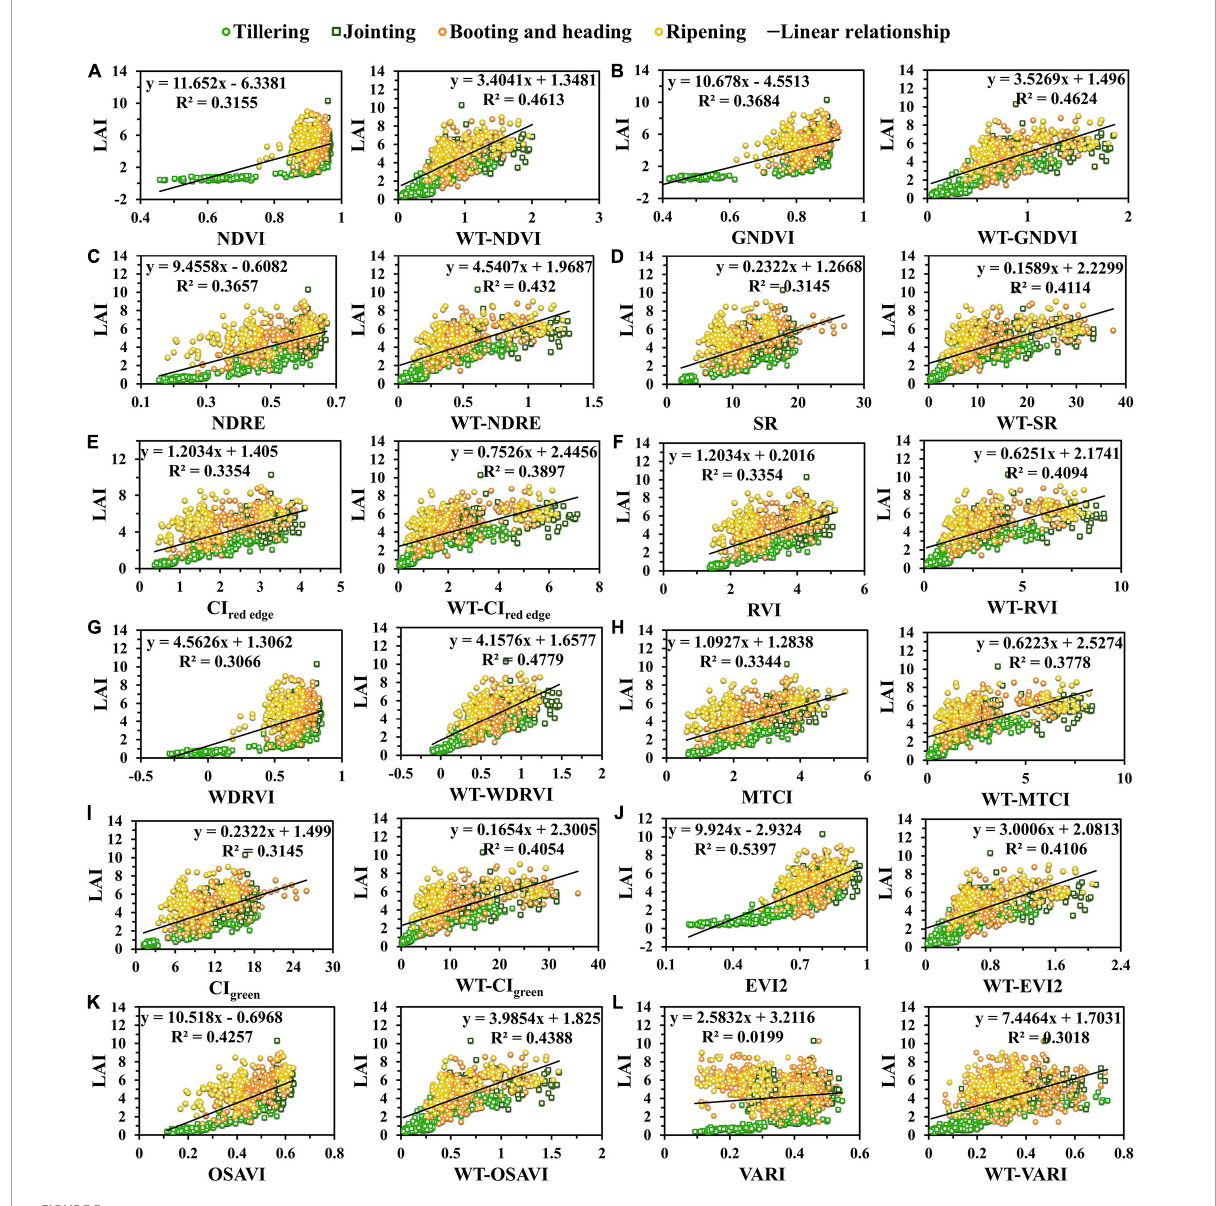
FIGURE5 Two models of VIs and WT-VIs: (A) NDVI, (B) GNDVI, (C) NDRE, (D) SR, (E) CI rededge , (F) RVI, (G) WDRVI, (H) MTCI, (I) CI green , (J) EVI2, (K) OSAVI, and (L) VARI. The scattered points were marked with four colors according to the growth stages of rice: tillering, jointing, booting and heading, and